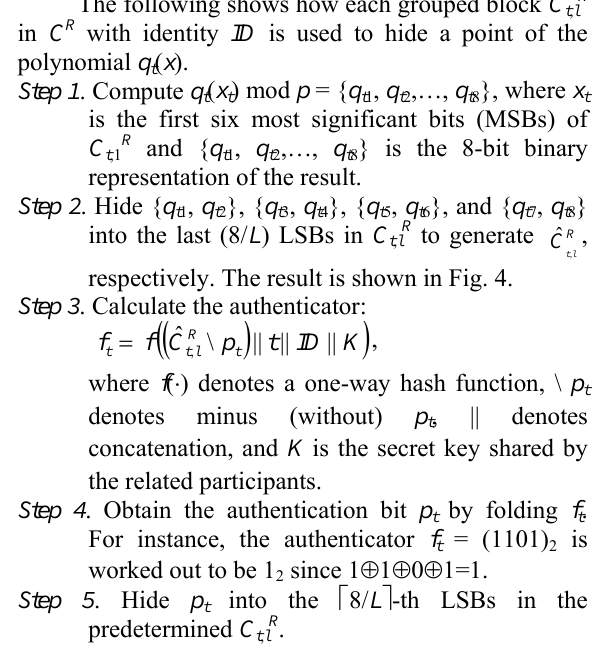
Procedure 1. Color